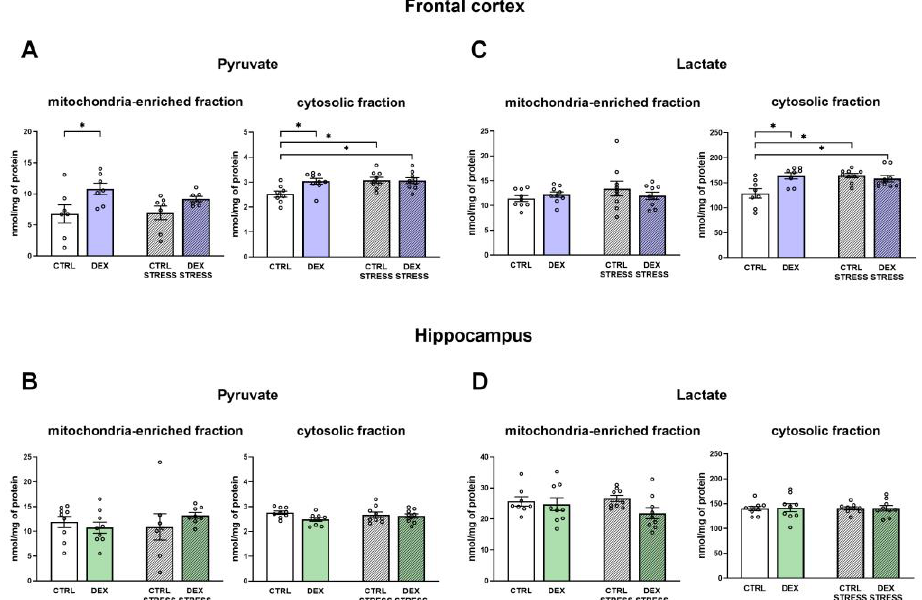
Figure 5. The effects of DEX treatment and acute stress on pyruvate and lactate levels in the mitochondria-enriched and cytosolic fractions of the frontal cortex ( A , C ) and the hippocampus ( B , D ); lactate and pyruvate levels were determined via colorimetric and fluorometric measurements, respectively; * p < 0.05, n = 7 – 9. The results are expressed as the mean ± SEM. Statistics: two-way ANOVA, followed by the Duncan test.